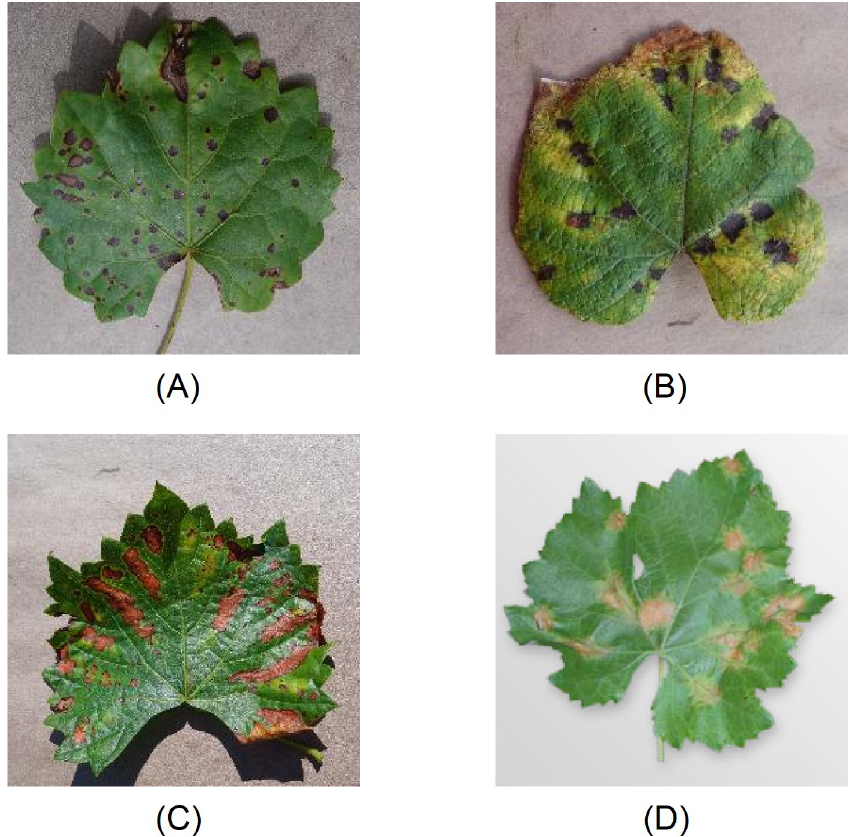
Fig 5. Examples of lesions on grape leaf caused by various infectious diseases. (A) Black rot (Guignardia bidwellii), (B) Leaf blight (Pseudocercospora vitis), (C) Esca (Phaeomoniella spp.), and (D) Downy mildew (Plasmopara viticola).